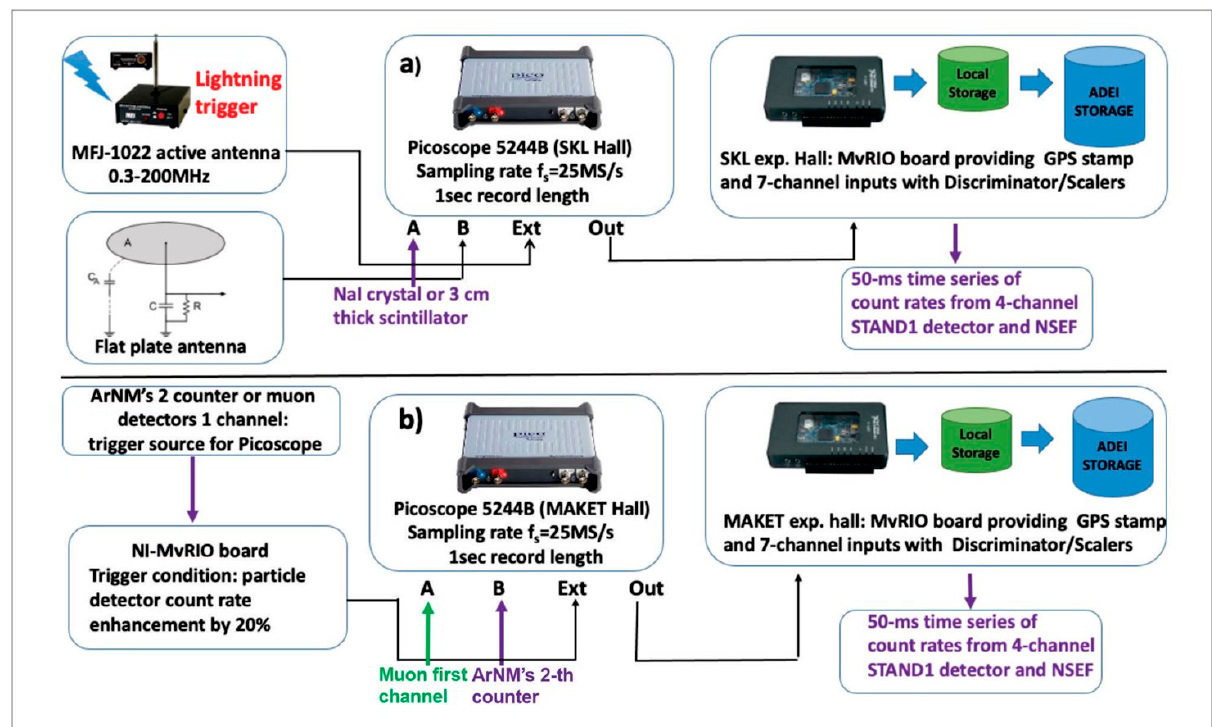
Figure 12. ( a ) Components of the Fast Synchronized Data Acquisition (FSDAQ) system for studying the coupling of particles and lightning flashes; ( b ) A similar system triggered by a TGE.